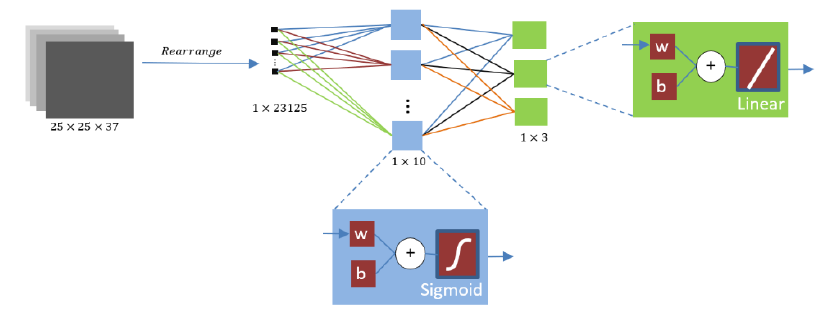
Figure 4. Feed forward neural network structure. Hidden and output nodes are magnified as blue and green boxes